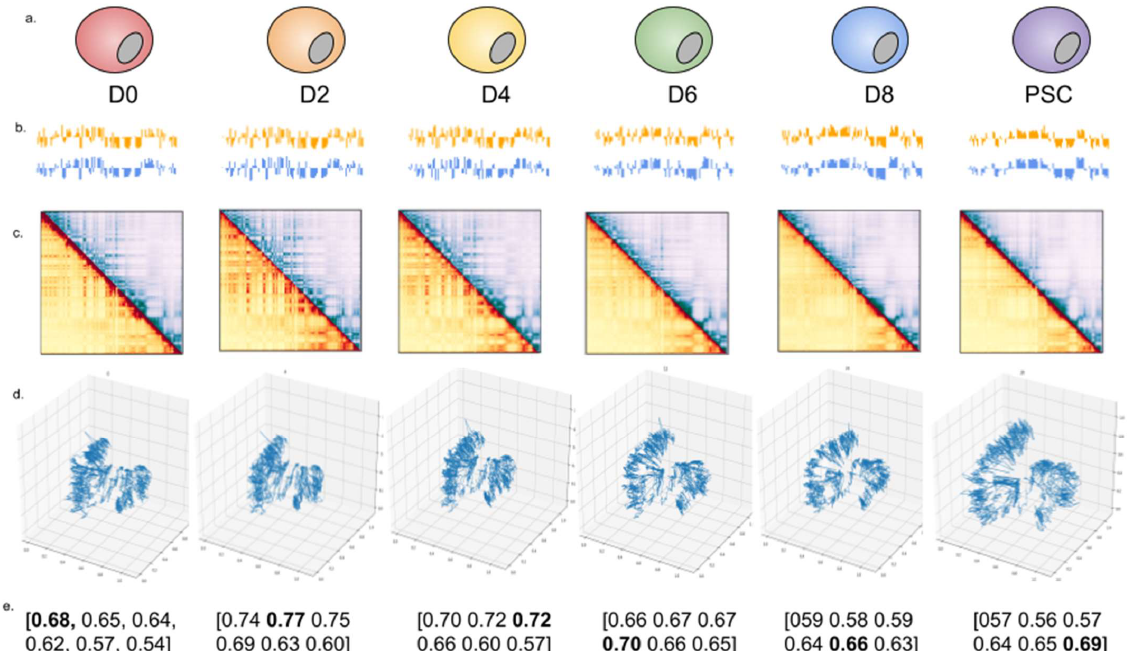
Figure 2. Diagram of outputs. ( a ) Outline of the different stages of the iPSC dataset of Mus Musculus. ( b ) AB compartment vectors of (orange) original and (blue) reconstructed contact maps. ( c ) 50 kb contact map of chromosome 13 by time, using (orange) original and (blue) reconstructed contact maps. ( d ) 4DMax prediction of structural conformation of chromosome 13 at time. ( e ) Spearman correlation between the above reconstructed contact map and the real contact maps at each time point.